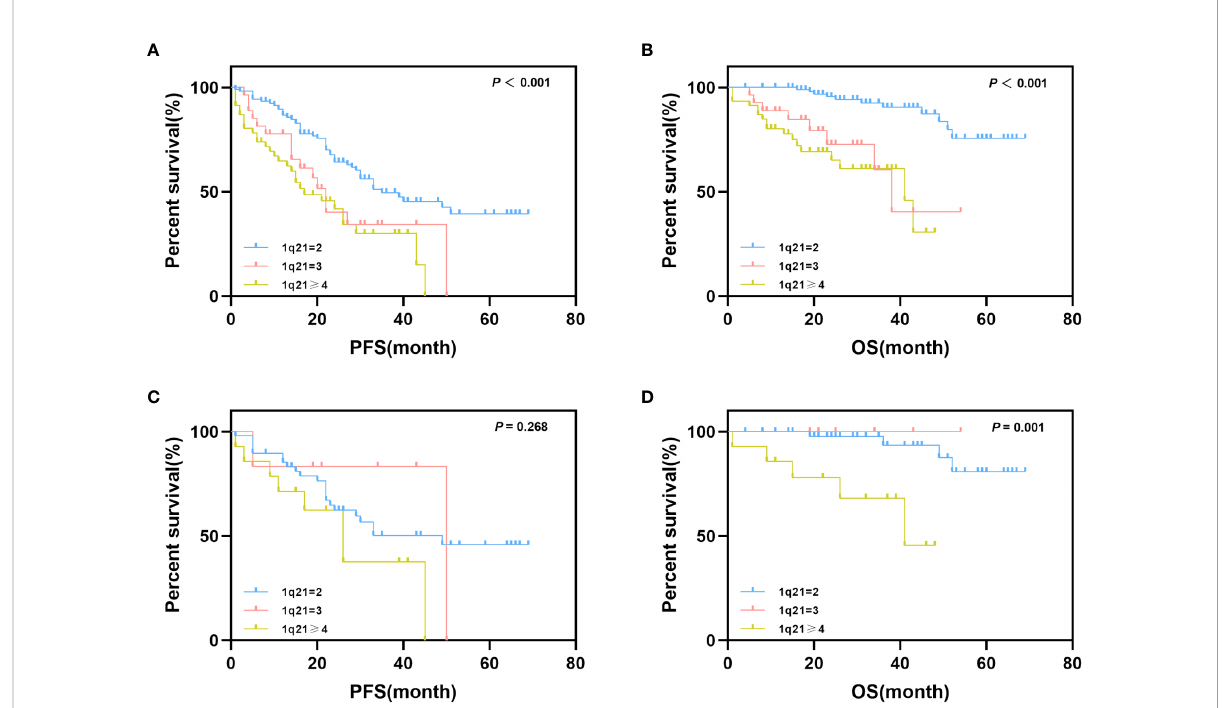
FIGURE 2 Impact of 1q21 gain copy numbers on PFS and OS. (A, B) Kaplan – Meier curves are shown for PFS and OS for patients with different copy numbers of 1q21 gain. (C, D) Kaplan – Meier curves are shown for PFS and OS for isolated 1q21 gain patients and FISH-negative patients with different copy numbers of 1q21 gain.